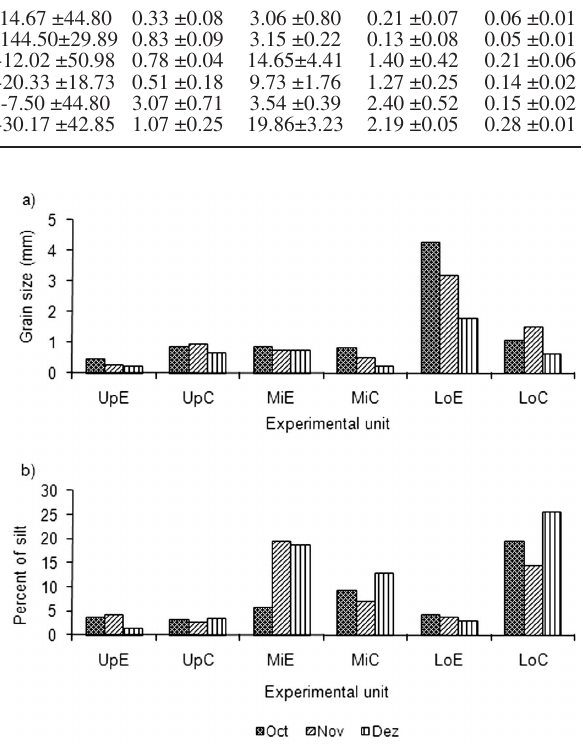
Fig . 3. – Evolution over time of changes in the third quartile of sedi- ment grain size (a) and percentage of silt from each experimental unit (b). E, Excavated; C, Control. Intertidal levels: Up, Upper; Mi, Middle; Lo,